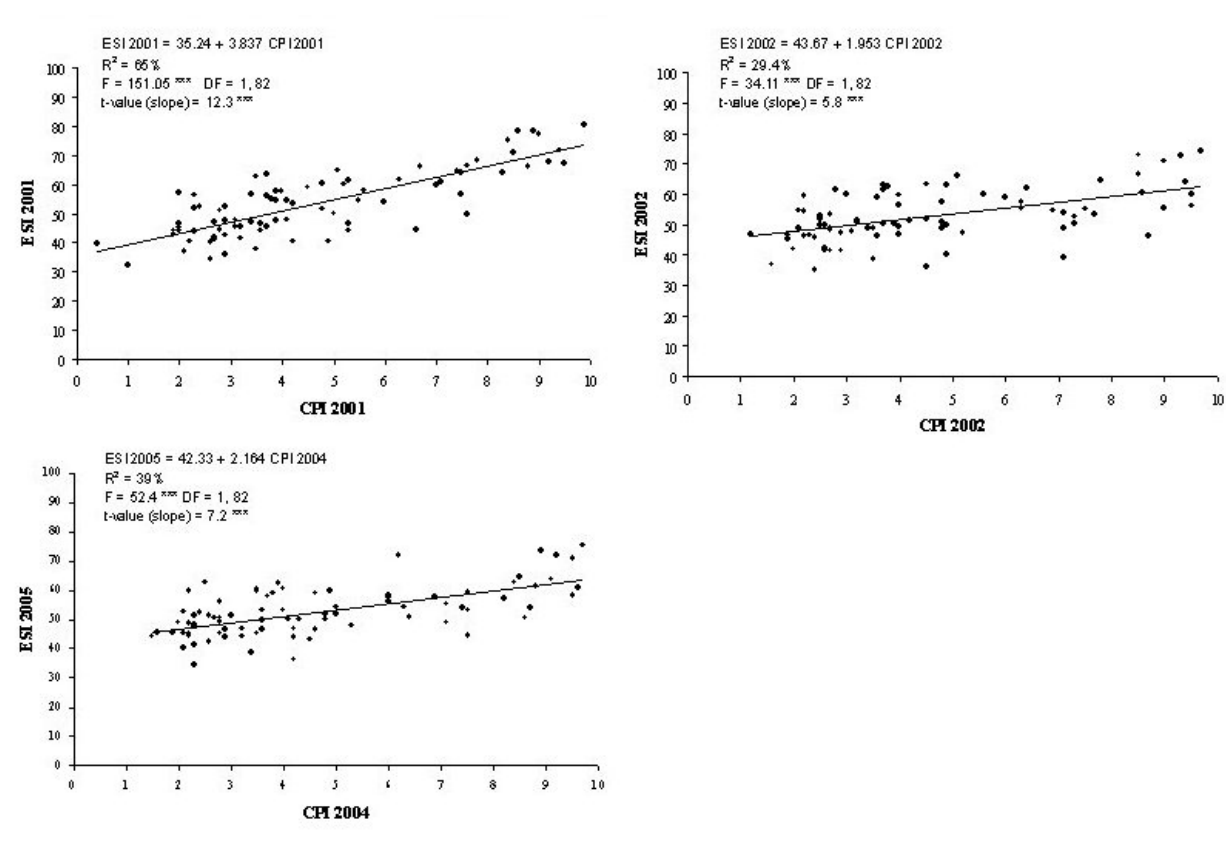
Fig. 2. Environmental Sustainability Index (ESI) as a function of Corruption Perception Index (CPI). CPI: scale from 0 (most corrupt) to 10 (least corrupt). ESI: scale from 0 (least sustainable) to 100 (most